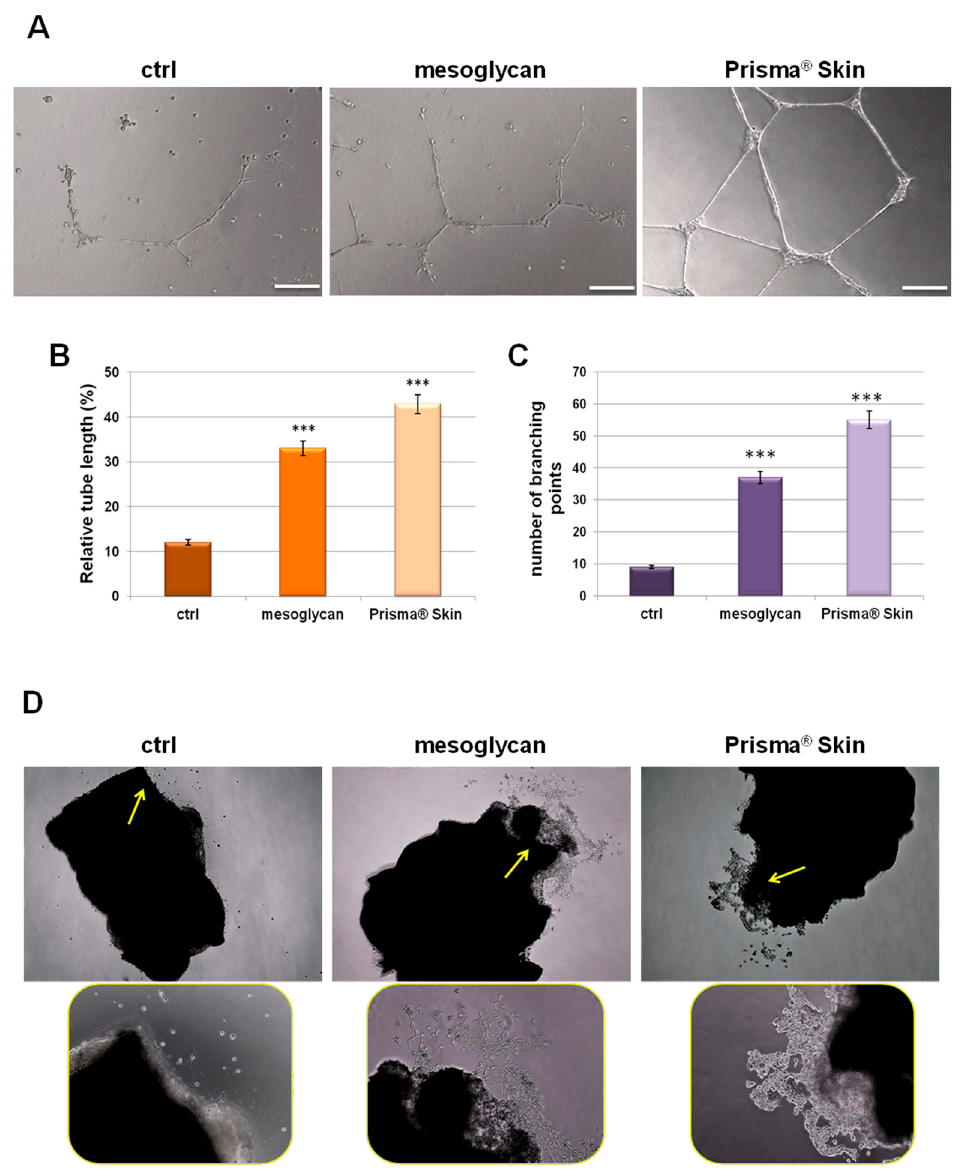
Figure 4. ( A ) Representative images of tube formation by HUVEC cells seeded for 12 h on matrigel: EBM-2 1:1 and treated or not with sodium mesoglycan and Prisma ® Skin 0.3 mg/mL. Bar: 100 µ m. Analysis of: ( B ) tube length; and ( C ) number of branches calculated by ImageJ (Angiogenesis Analyzer tool) software. Data represent the mean of three independent experiments ± SEM with similar results. *** p < 0.001; ( D ) Representative bright field images of mouse aortic sections captured at EVOS light microscope 4 × (rectangular pictures) and 10 × (rounded pictures are enlargements of areas indicated by yellow arrows).